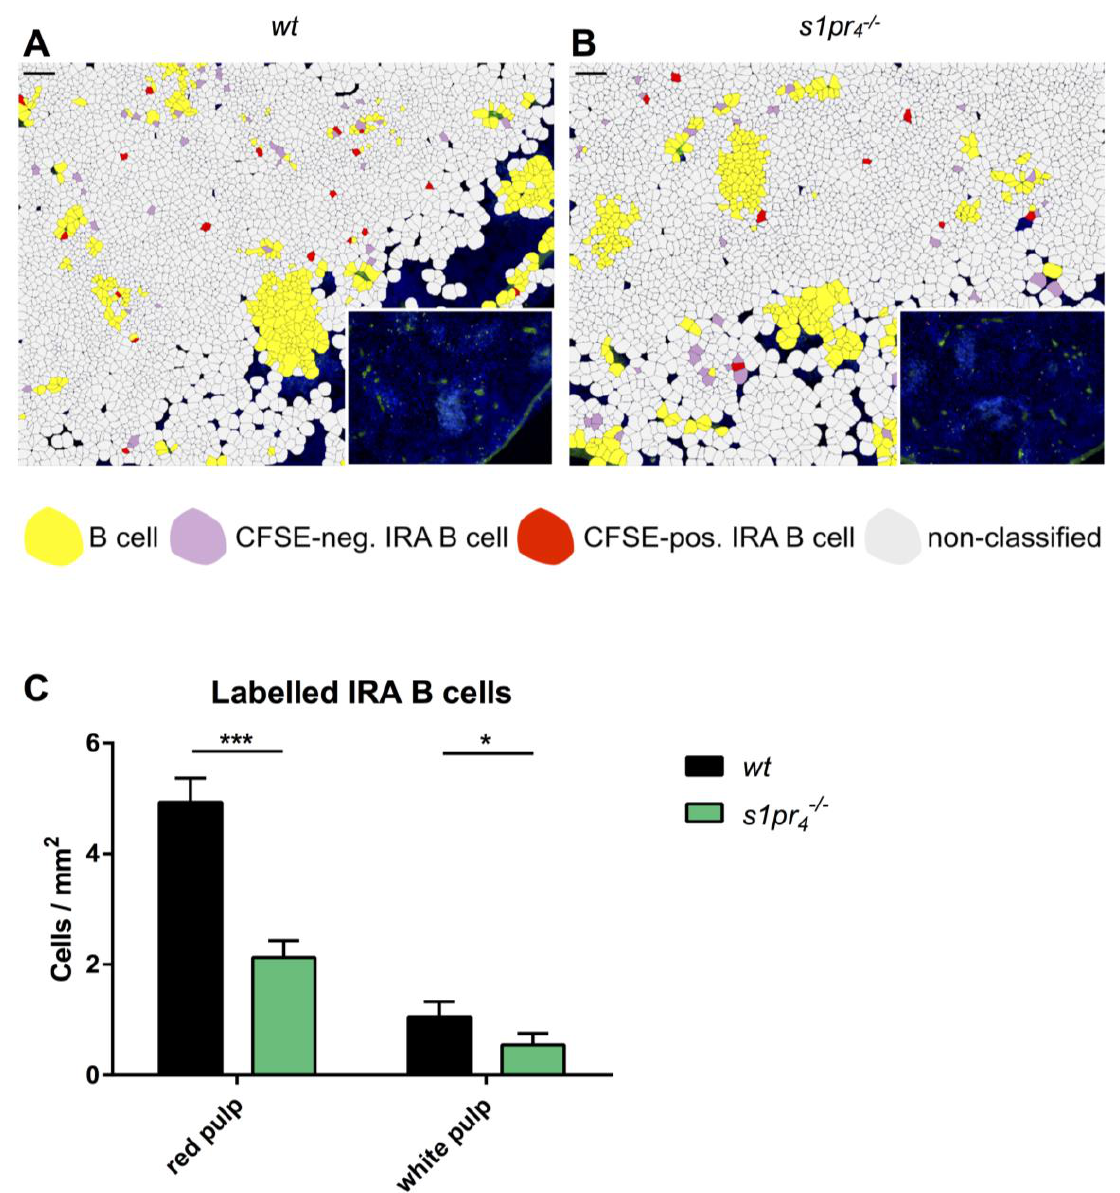
Figure 6. Analysis of the localization of splenic IRA B cells derived from transferred peritoneal B cells. After the adoptive cells of wt ( A ) and s1pr 4−/− ( B ) peritoneal cells and subsequent LPS stimulation, spleen sections (3 µm) were stained with anti-B220 (green), anti-GM-CSF (red) and anti-FITC (white), while nuclei were stained with DAPI (blue) (black scale bar equals 50 µm). To improve visualization of spatial cell distribution, cell maps of the tissue sections (created using QuPath) are shown, with the original images displayed in the bottom corner. Cells were segmented based on DAPI staining and then classified according to their cytoplasmic staining. “B cells” were identified as B220 + CFSE − GM-CSF − , “CFSE-neg. IRA B cells” as B220 + CFSE − GM-CSF + and “CFSE-pos. IRA B cells” as B220 + CFSE + GM-CSF + . The remaining cells were designated as “non classified”. ( C ) Based on the aforementioned classification, the number of cells per mm 2 was calculated and then compared between the genotypes. A total of 10 representative images in two sectional planes per animal were recorded as technical replicates, and their mean value was further used as a single biological replicate. Results shown are the mean values (+SEM) of these biological replicates for n = 10 animals per group. * p < 0.05, *** p < 0.001.